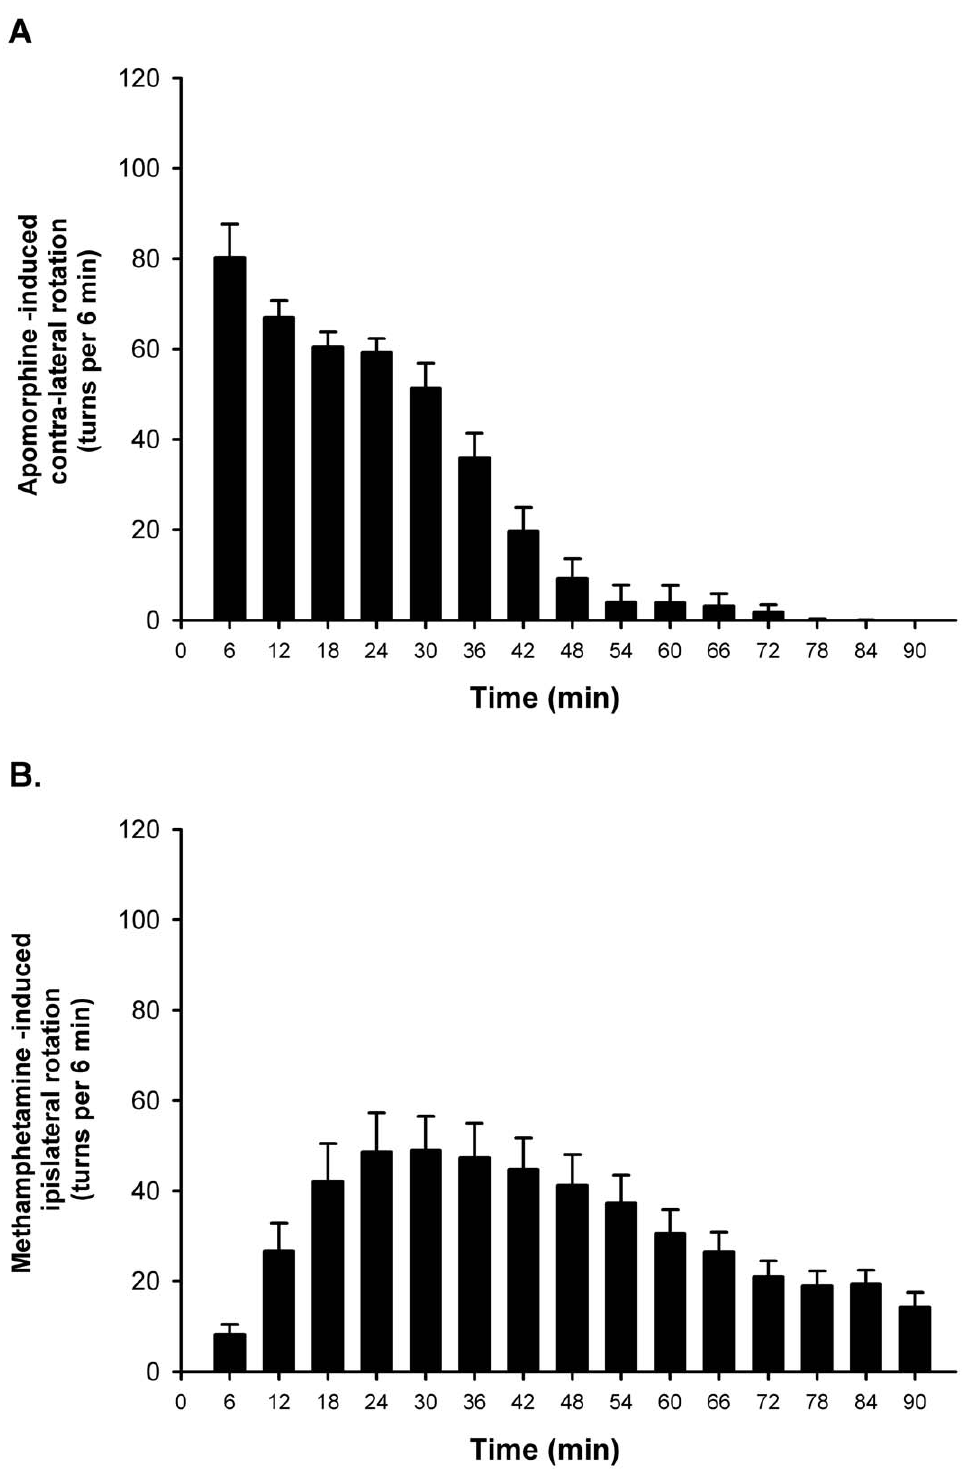
Figure 1. Apomorphine- and methamphetamine-induced rotations in 6-OHDA hemiparkinsonian rats. The animals were injected with 6-OHDA as described in the text. Rotation was measured after injection of apomorphine (APO) (0.05 mg/kg) (A) or methamphetamine (METH) (2.5 mg/kg) (B).